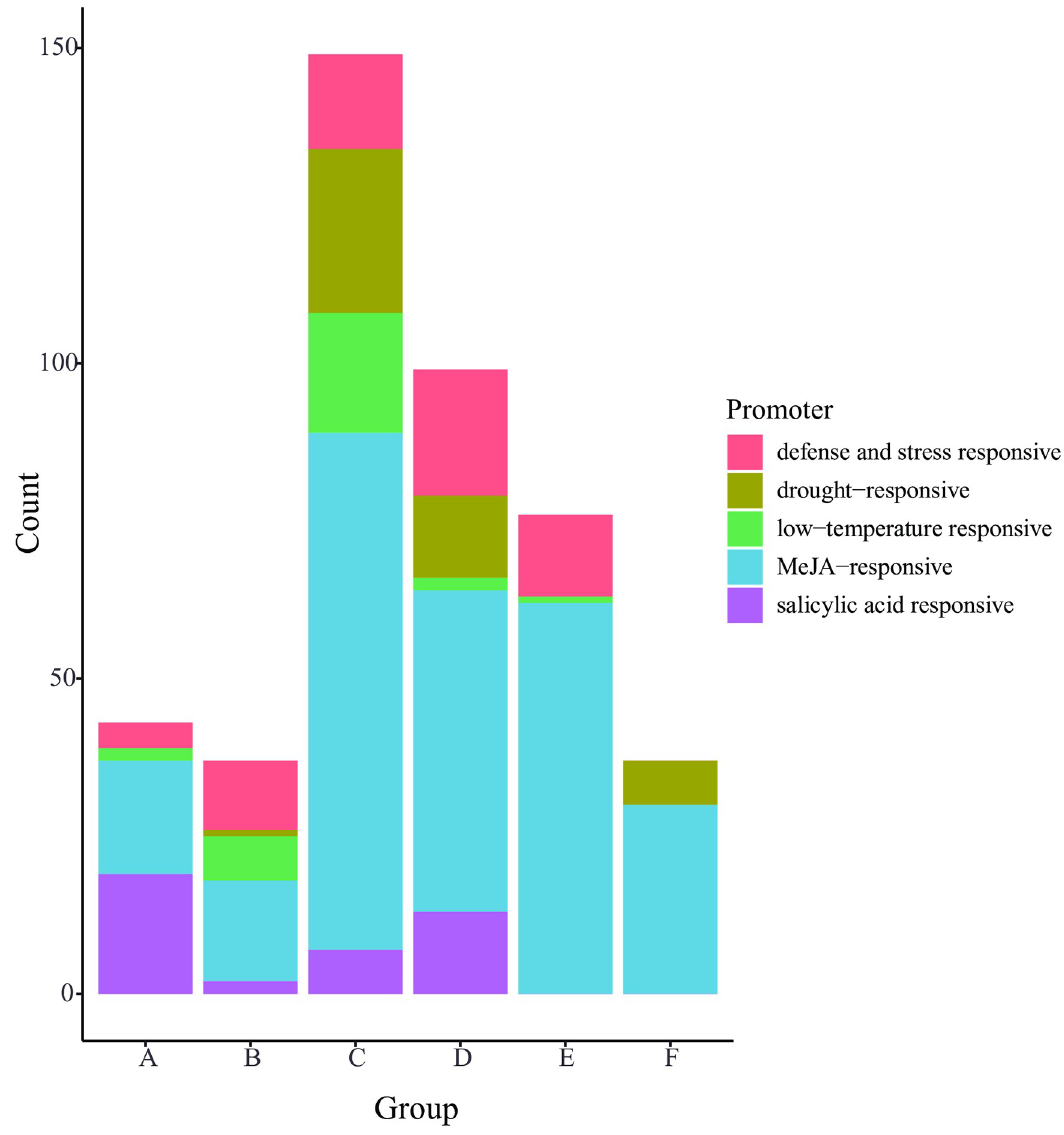
Fig 6. Number of MIOX gene cis-elements in each